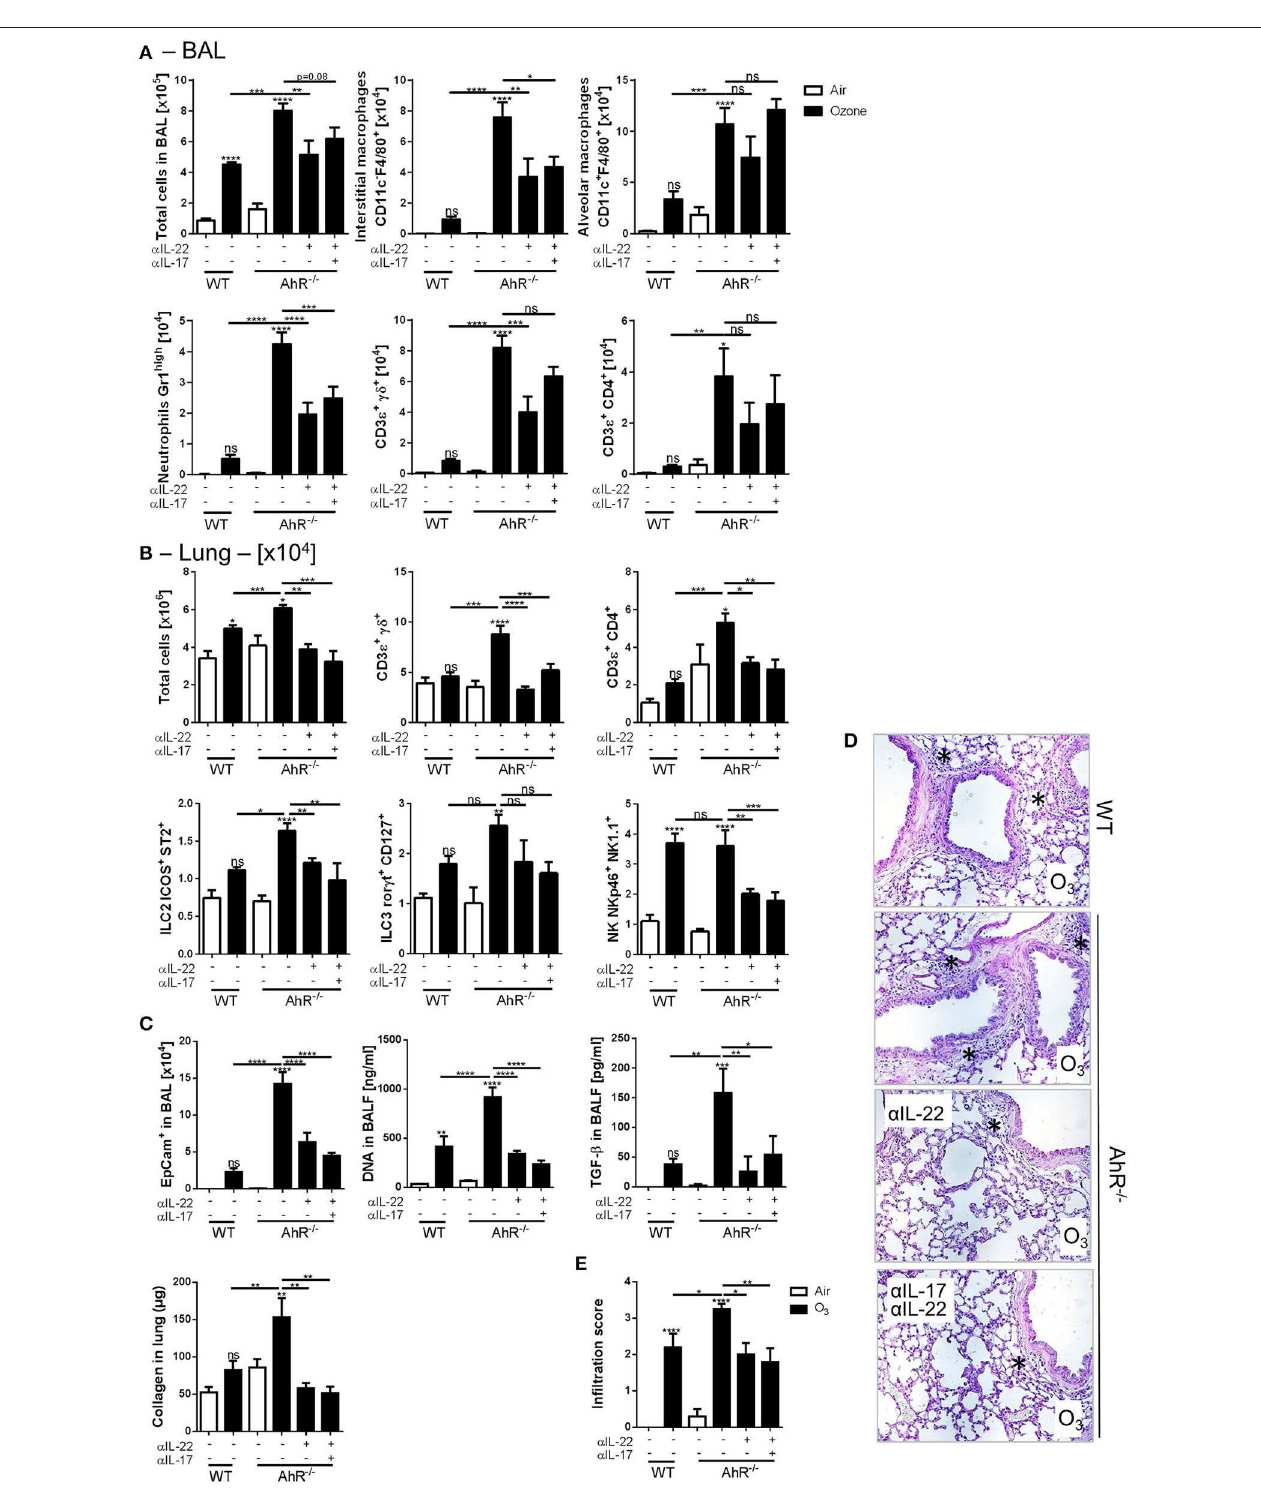
FIGURE 6 | IL-22 and IL-17A neutralization in AhR deficient mice. BAL cells recruitment (total cells, macrophages, neutrophils, and T cells) (A) . Lung cell recruitment (total cells, neutrophils, macrophages, ILC2, ILC3, αβ , and γδ T cells) (B) , and remodeling parameters (epithelial cells, DNA, and collagen in lung) (C) ; lung histology (400 × magnification; asterisks show cell infiltration) (D) and cell infiltration score (E) after ozone exposure in WT and AhR-deficient mice. The data are representative of one from two independent experiments with n = 5–6 mice per group. Values are expressed as mean ± SEM.